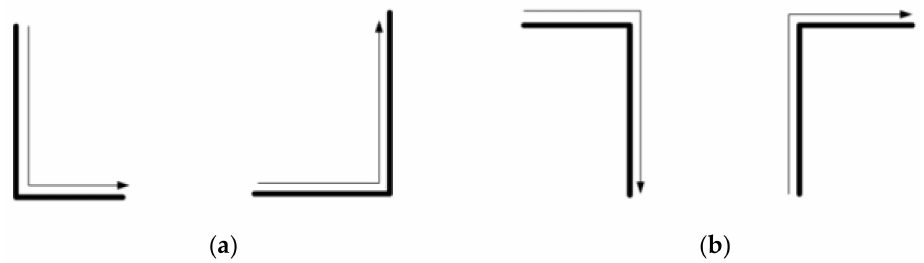
Figure 5. ( a ) Moving along the inner boundary; ( b ) moving along the outer